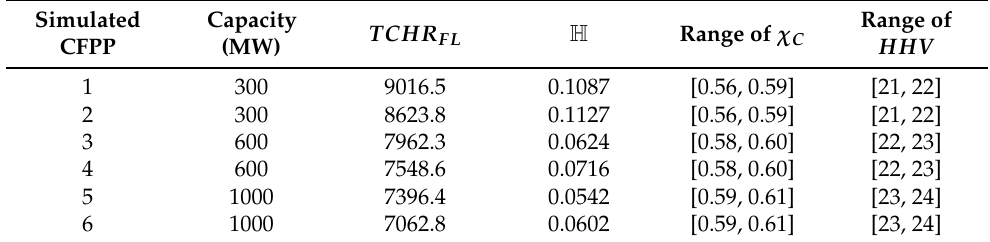
Table 1. The range of simulation parameters used in the physical variable model.